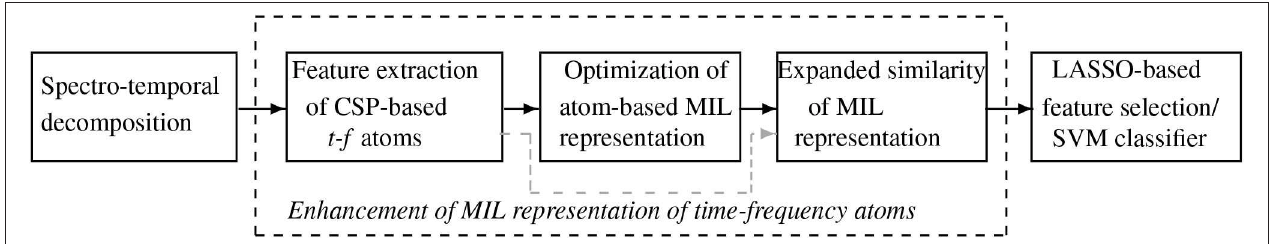
FIGURE 1 | Scheme of bag-of-patterns representation proposed for classification of bi-class motor imagery tasks. Within the MIL framework using t-f atoms, the suggested improvement is remarked by a dashed box.